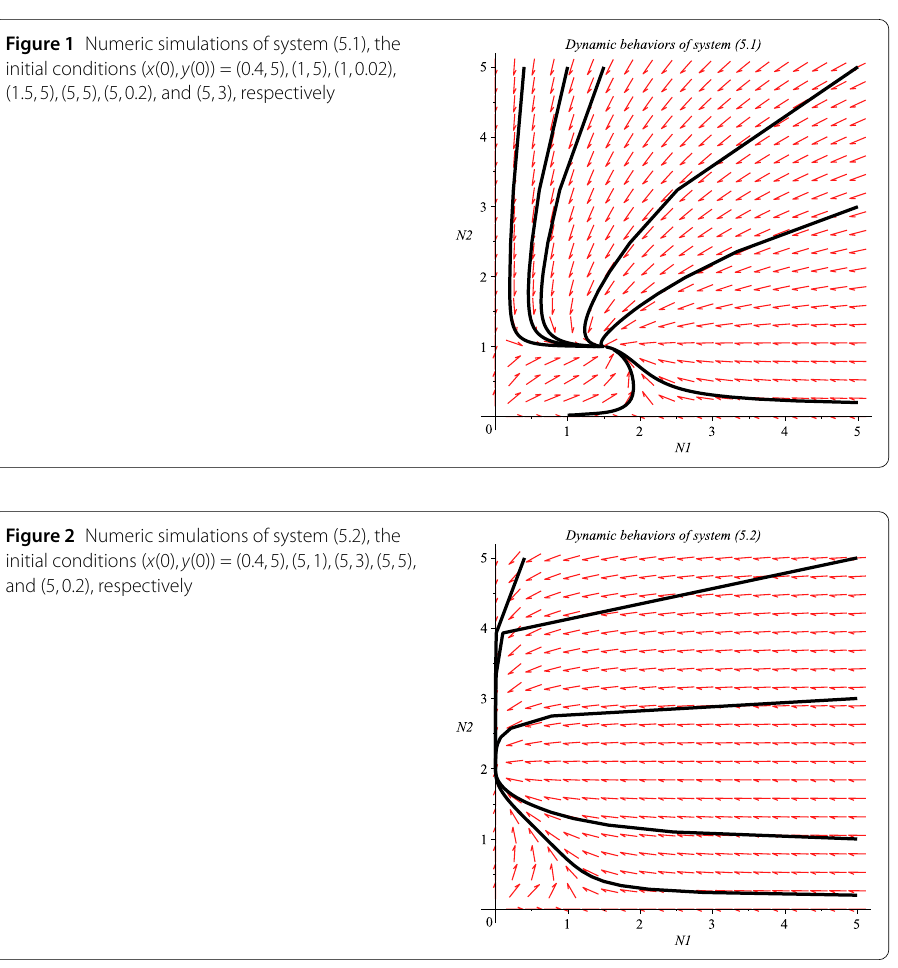
Figure 1 Numeric simulations of system (5.1), the initial conditions ( x (0), y (0)) = (0.4,5),(1,5),(1,0.02), (1.5,5),(5,5),(5,0.2), and (5,3), respectively